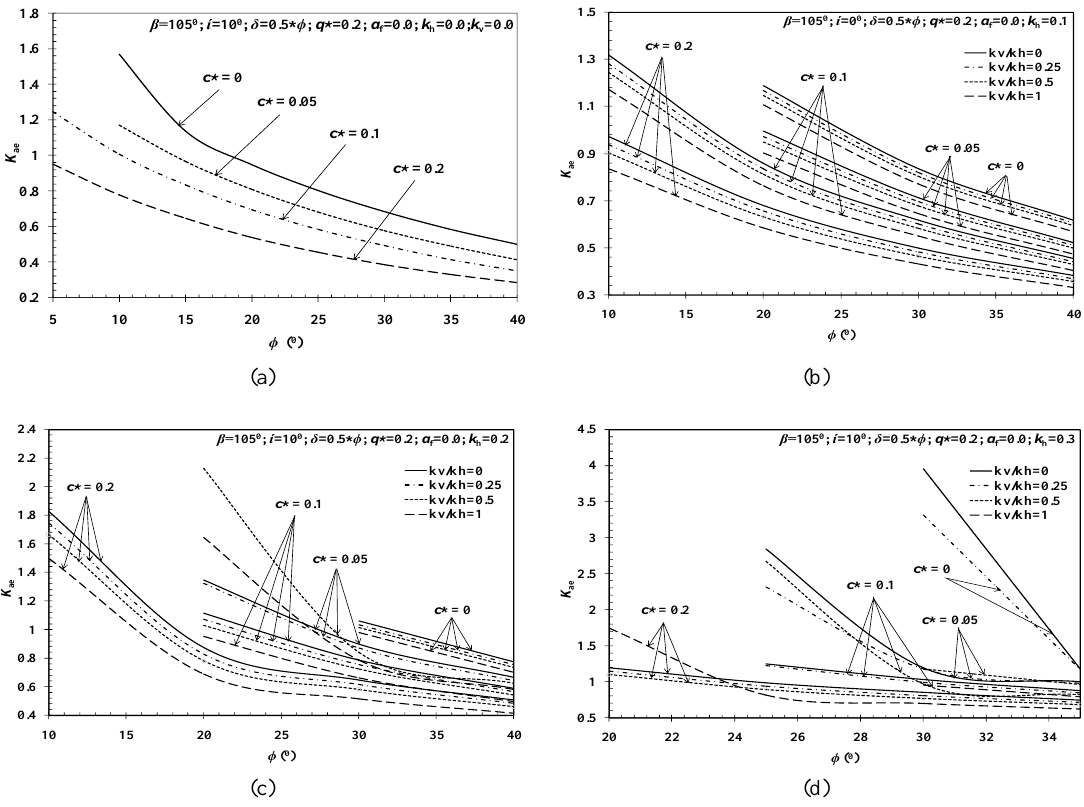
Figure 6. Design charts for K ae for backfill slope i = 10 o and wall inclination β = 105